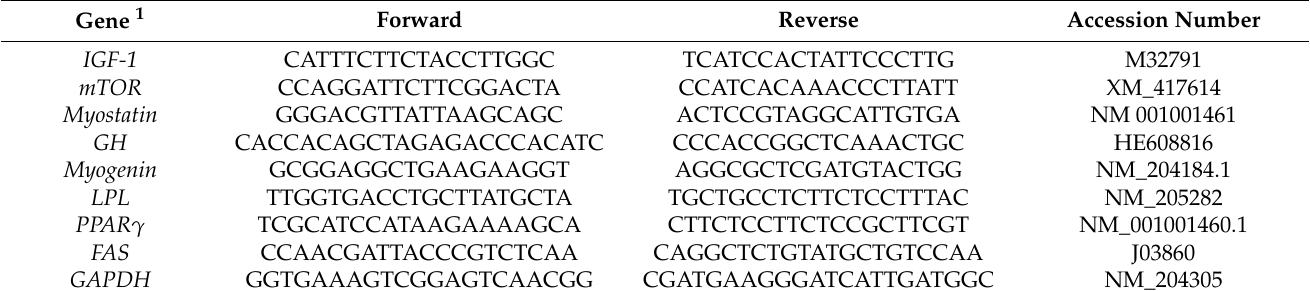
Table 2. Primers sequences and target genes for SYBR green RT-PCR.